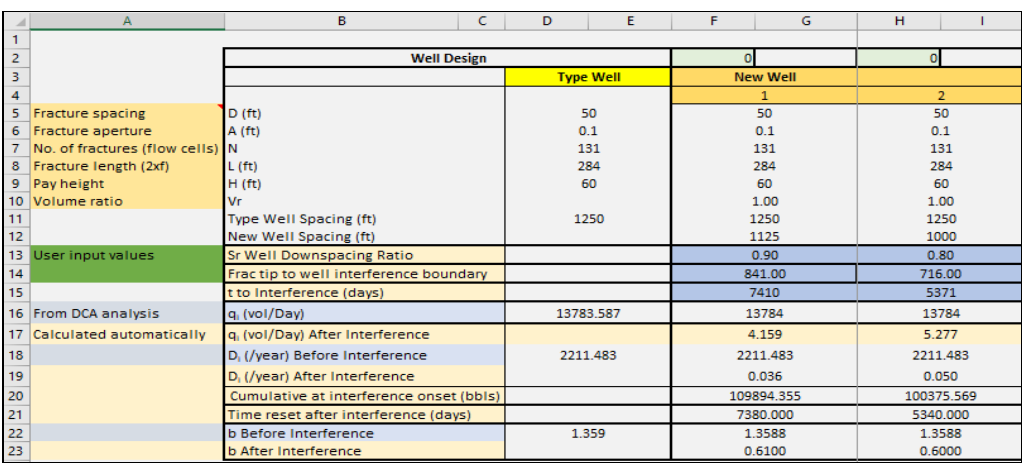
Figure A3 . Screen capture of the cells requiring user input in the “Down -s pacing ratio” tab with additional Figure A3. Screen capture of the cells requiring user input in the “Down-spacing ratio” tab with columns showing down-spacing well values alongside type well values. additional columns showing down-spacing well values alongside type well values.